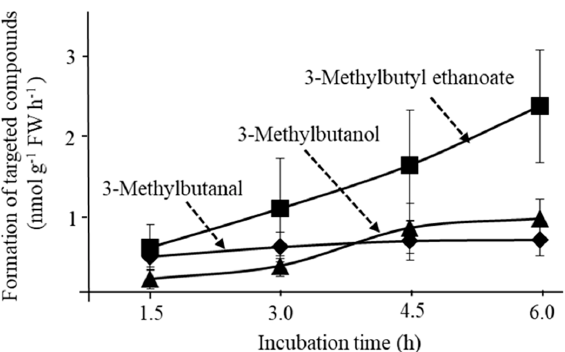
Figure 7. Formation of 3-methylbutanol, 3-methylbutanal and 3-methylbutyl ethanoate from exogenous 2-keto-4-methylpentanoic acid (50 nmol) after incubation with pulp slices (10 g) of bananas at the “yellow with green tips” stage. Vertical line at each marker shows average ± standard deviation (n = 3).